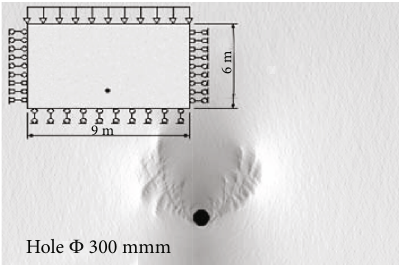
Figure 9: 300mm maximum principal stress for boreholes.